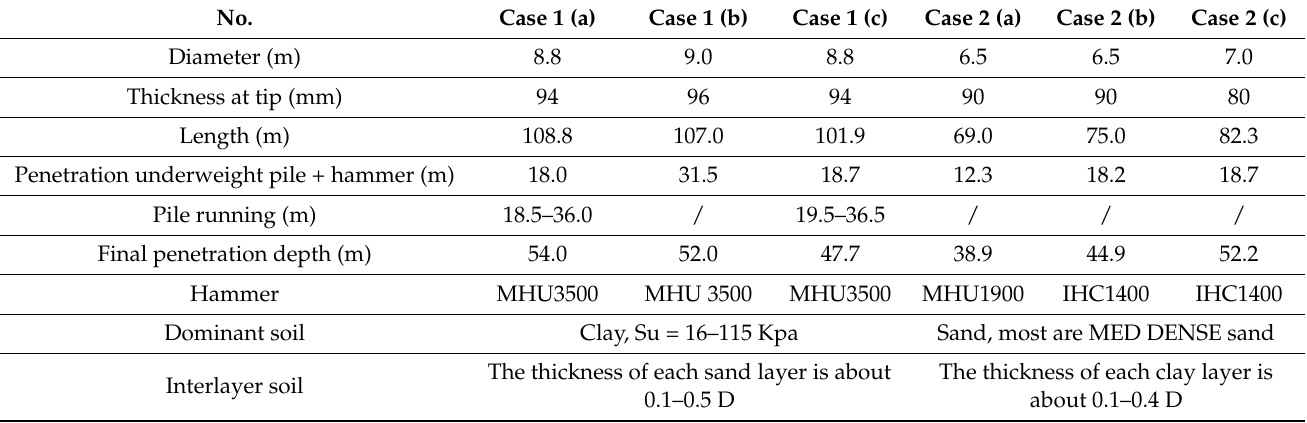
Table 1. Monopiles used for back-analysis.